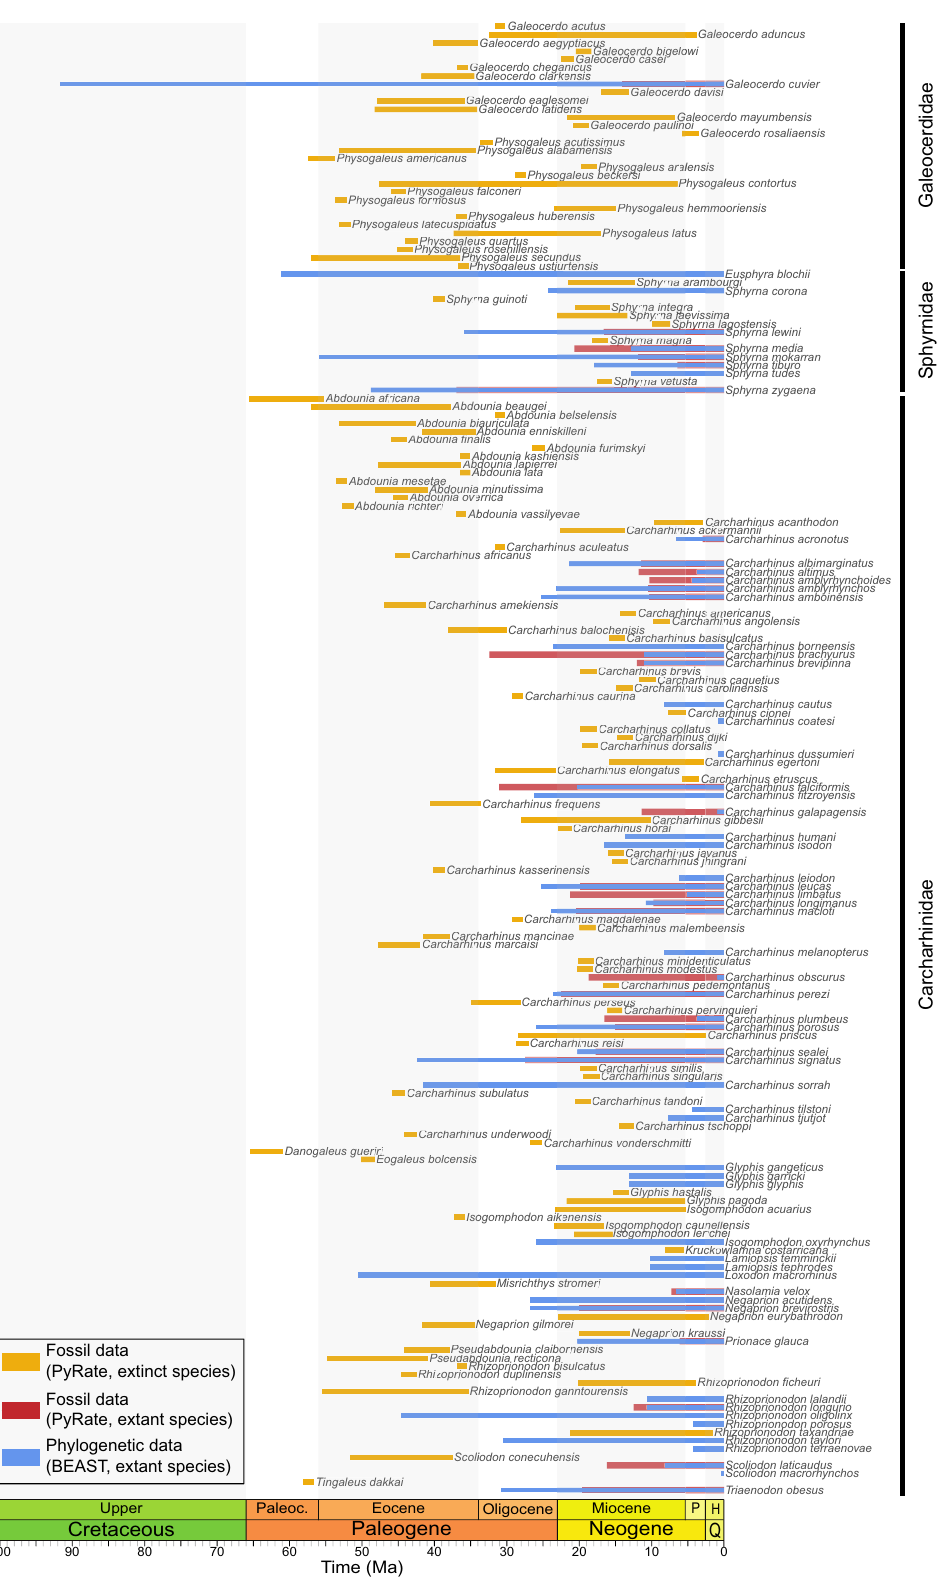
Figure 6. Estimates of species lifespan from the fossil record and the molecular phylogeny for the clade gathering Galeocerdidae, Sphyrnidae, and Carcharhinidae. Species lifespan is determined by the times of speciation ( Ts ) and times of extinction ( Te ), as inferred with the fossil record for extinct species (yellow) and extant species having fossil occurrences (orange), and those inferred with the dated phylogeny for extant species only (blue). Summing up the number of species per million-year bins allows recovering the diversity dynamics of the clade through time. See Supplementary Data S14 for data on the entire